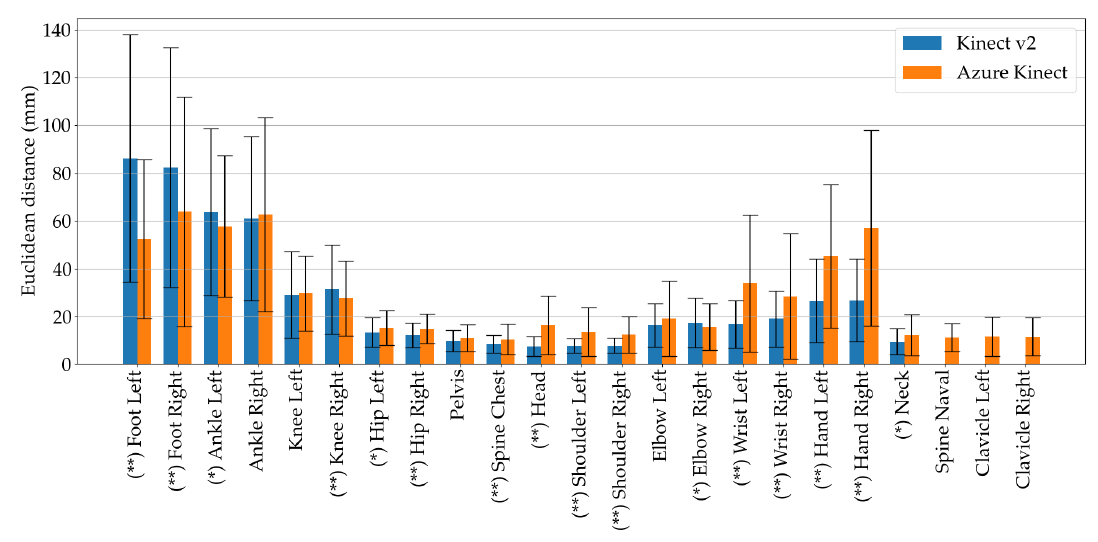
Figure 6. Spatial agreement of the Microsoft Kinect v2 and Azure Kinect cameras with respect to the Vicon system. Errors are represented as means and standard deviation of the 3D Euclidean distances between according joints.